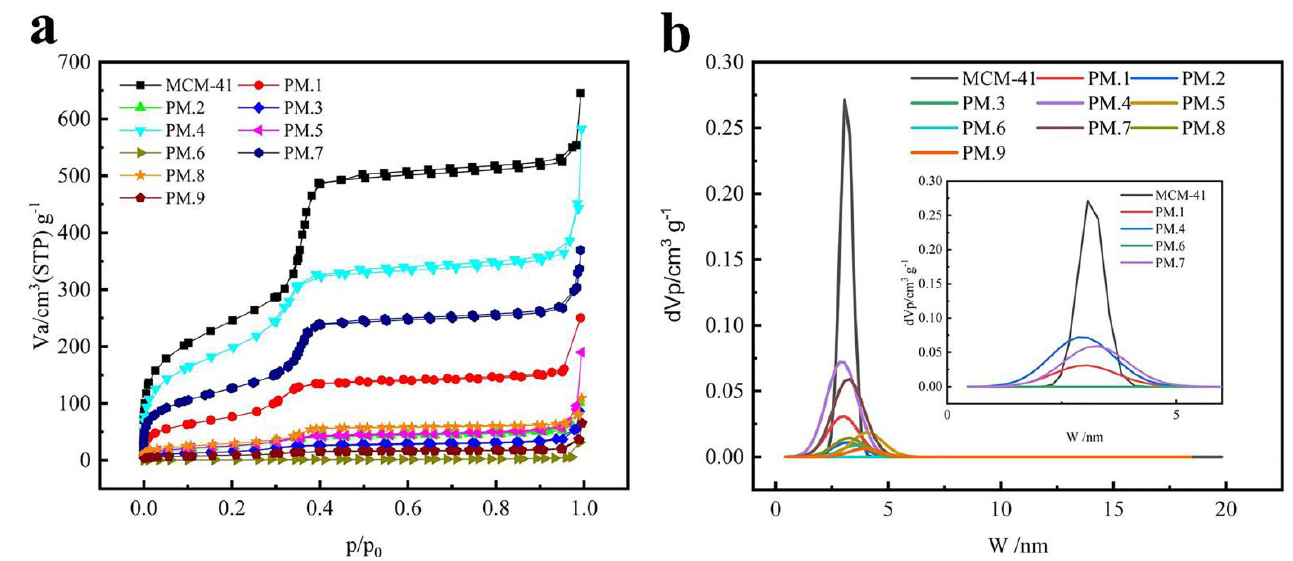
Figure 2. ( a ) N 2 adsorption/desorption isotherms and ( b ) pore size distribution of pure MCM-41 and phloridzin/MCM-41 assembly.